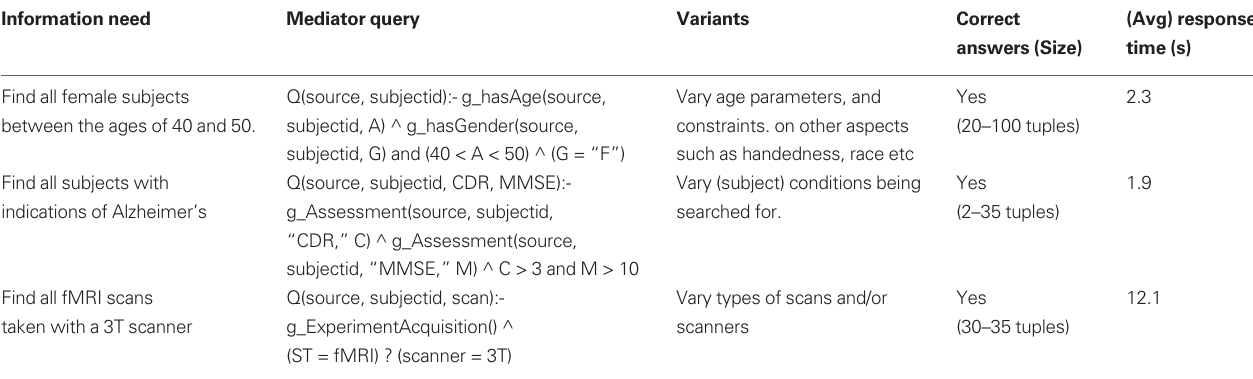
Table 2 | Mediator queries in FBirN.